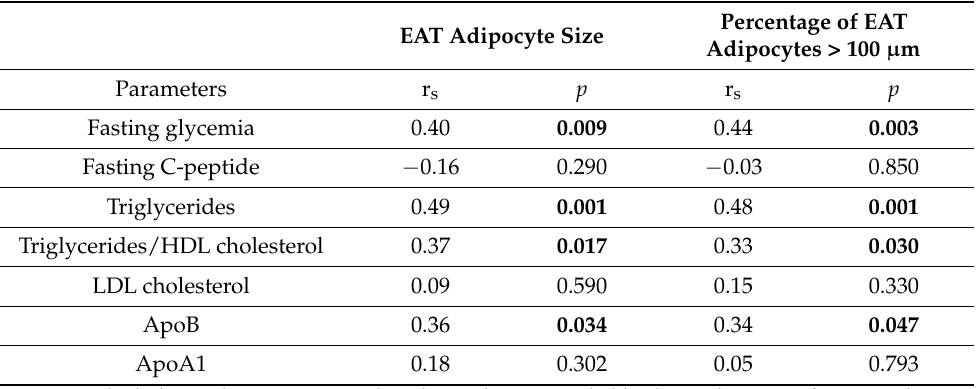
Table 5. Correlations of EAT adipocyte size, percentages of large adipocytes with metabolic parameters. Percentage of EAT EAT Adipocyte Size Adipocytes > 100 µ m Parameters r s p r s p Fasting glycemia 0.40 0.009 Fasting C-peptide − 0.16 0.290